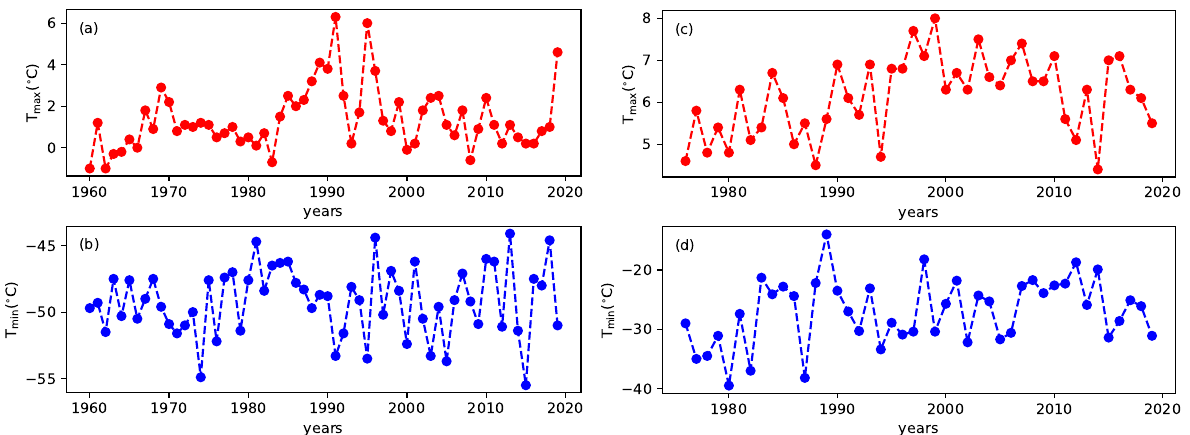
Figure 2. Annual maximum ( a ) and minimum ( b ) temperatures at Halley Met Station. Annual maximum ( c ) and minimum ( d ) temperatures at Rothera Met Station.